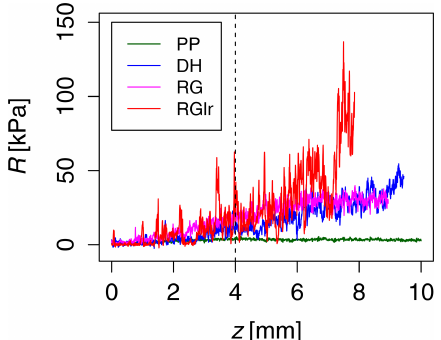
Figure 6. Segments of snow hardness profiles of PP1, DH1, RG1 and RGlr1. These four different types occur as natural snow types. Precipitation particles (PP) have the smallest trend and fluctuation force; large rounded grains (RGlr) are the largest, while depth hoar (DH) and rounded grains (RG) have similar trends and fluctuation forces between those of PP and RGlr. The first 4mm is affected by the progressive penetration of the conic tip and was not considered in the stochastic